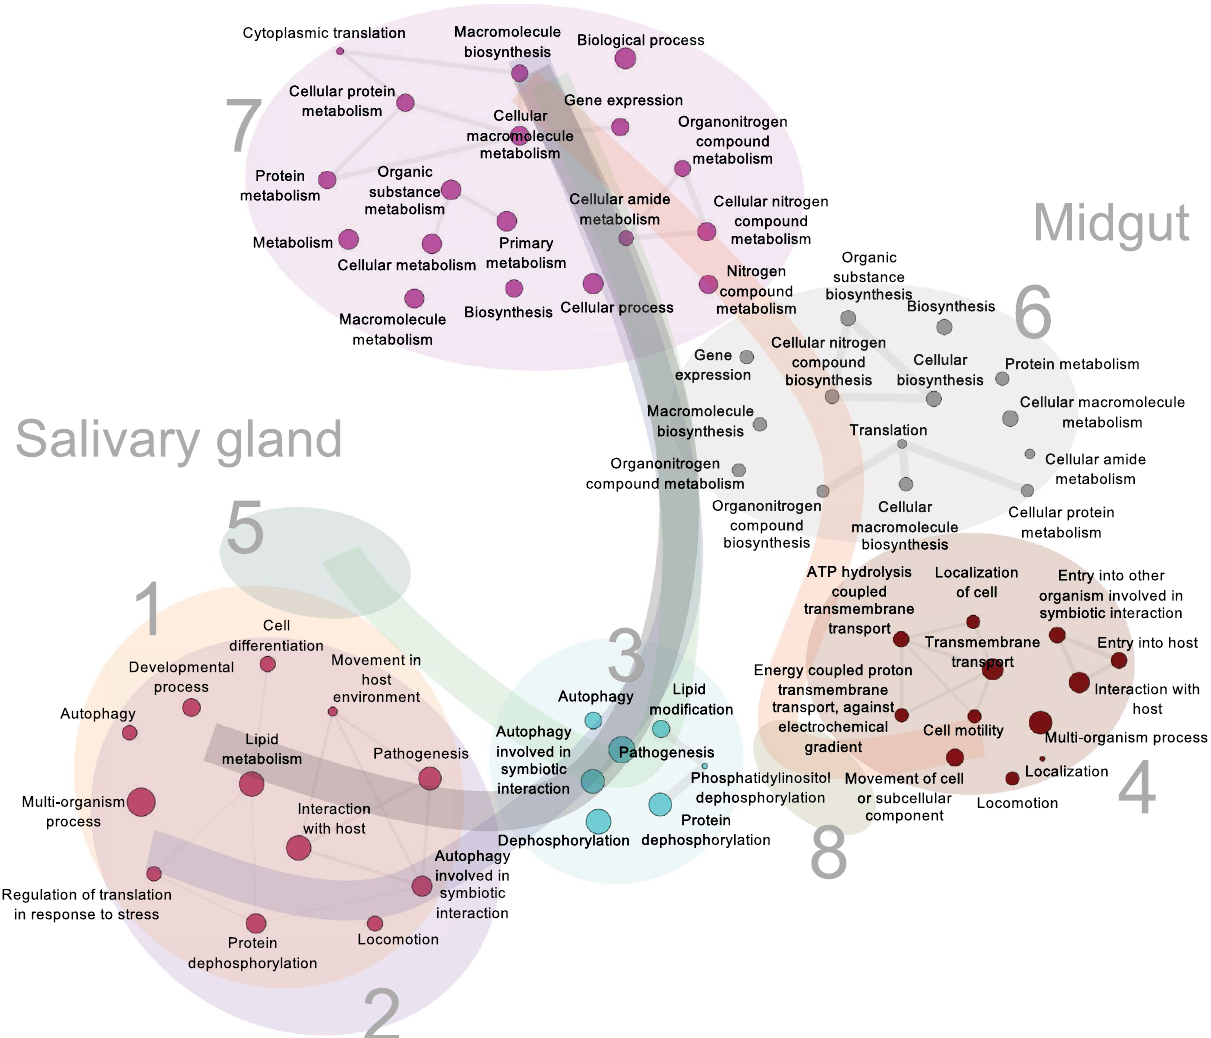
Figure 5. Enrichment analysis of SG and MID sporozoite markers. GO network analysis of enriched Biological Processes in sporozoite clusters. For clusters 1 and 2, markers co-occuring in these clusters were used to identify enriched BPs and the GO network analysis. Markers with an adjusted P value < 0.05 were used for gene set enrichment analysis. No significant enrichments were detected in cluster 5 and 8 using the current